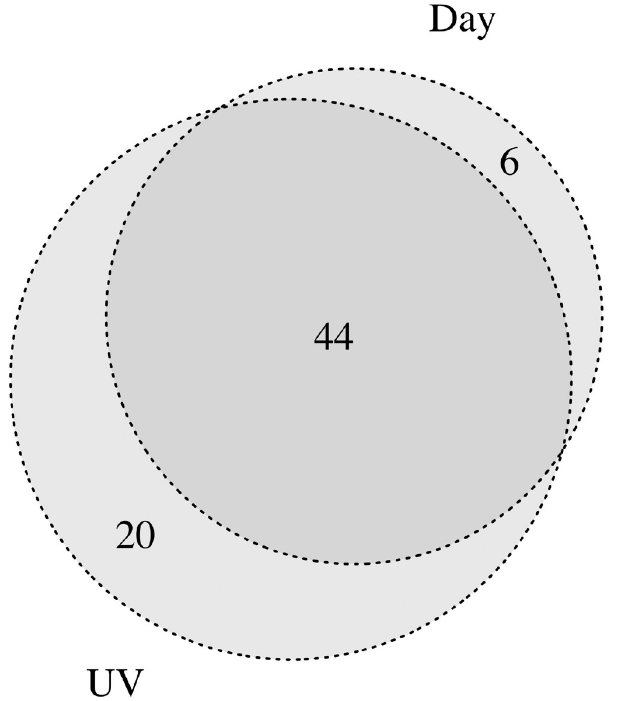
Fig. 7. Number of mantid species collected with the two main sampling methods: day capture (Day) and light trapping